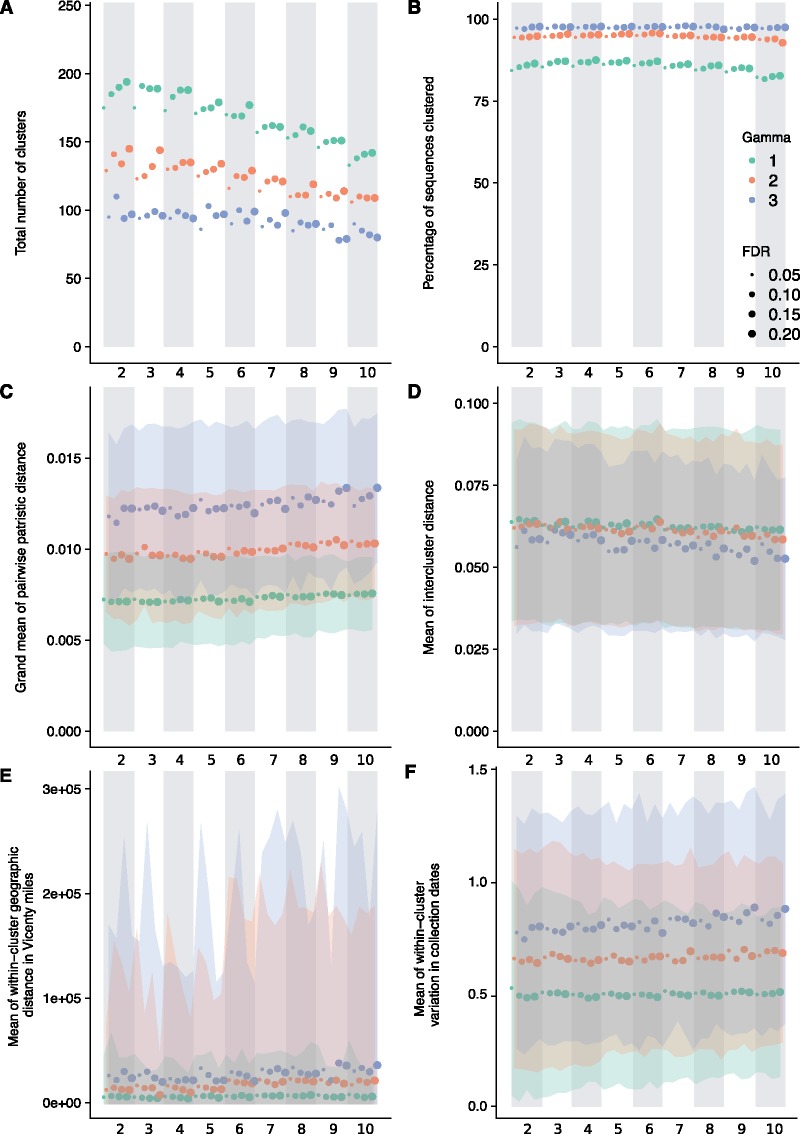
Influence of parameters on the clustering properties of PhyCLIP in the WHO/OIE/FAO 2015-update phylogeny. Figure A–F has the parameter set combinations ordered according to minimum cluster size, FDR and γ on the x-axis. The banded background and x-axis subscript numbering indicate the minimum cluster size of the parameter set. Marker color and size is indicative of the γ and the FDR respectively of the parameter set as indicated by the legend in figure B. (A) Total number of clusters. (B) Percentage of sequences clustered. (C) Grand mean of the pairwise patristic distance distribution. (D) Mean of the intercluster distance to all other clusters. (E) Mean within-cluster geographic distance calculated in Vicenty miles. (F) Mean within-cluster SD in collection dates.